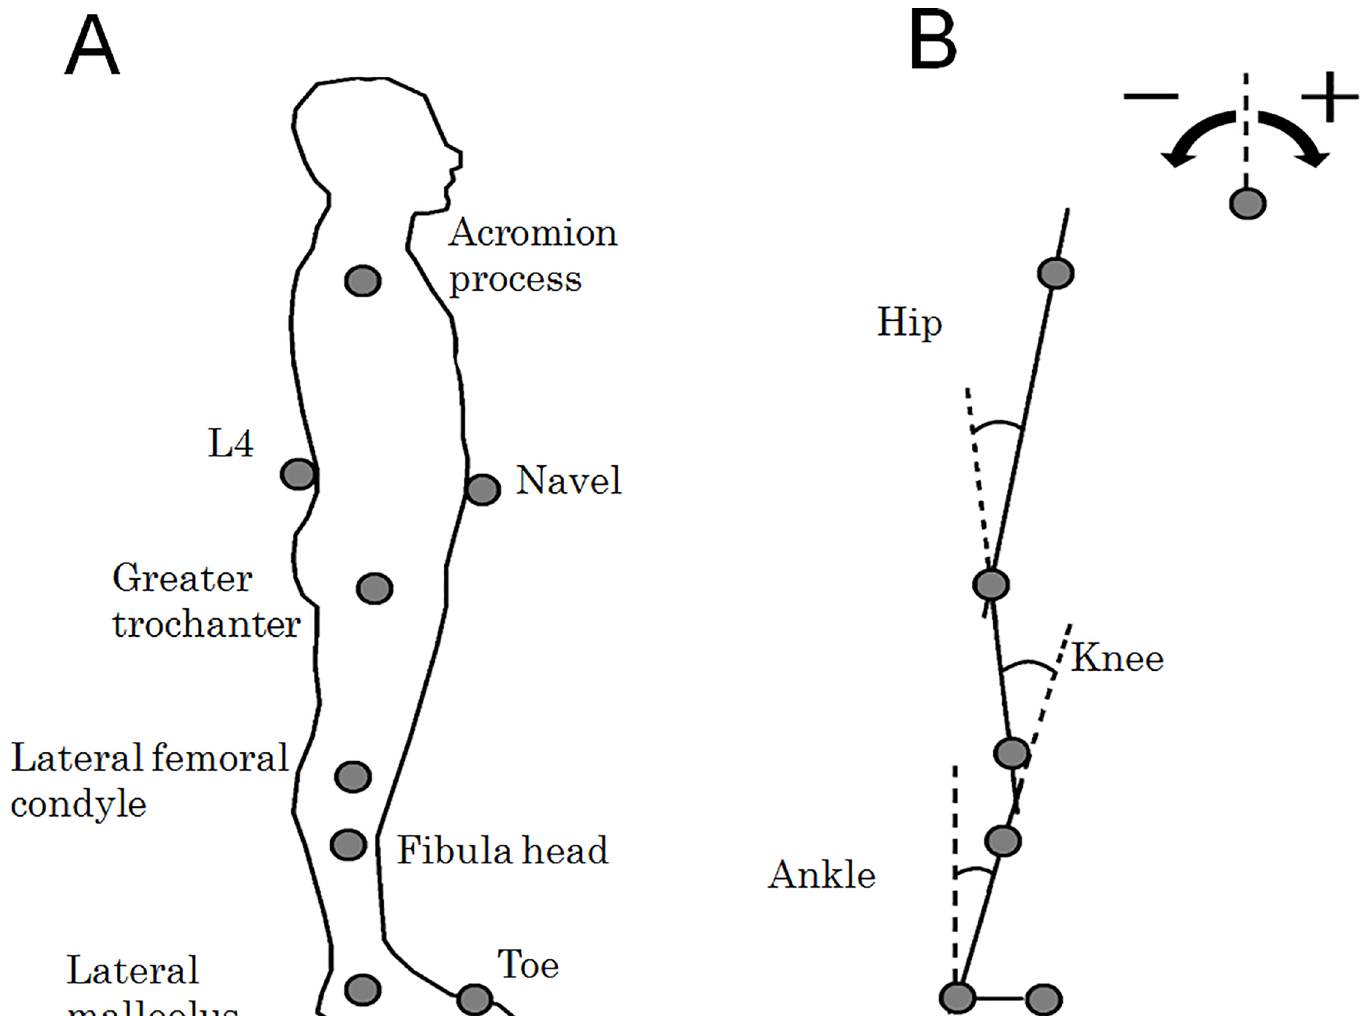
Fig 1. Experimental setup. (A) Marker placement: Eight reflective markers were placed over surface landmarks. The markers, except for L4 and the navel, were used to calculate the ankle, knee, and hip joint angles in the sagittal plane. The markers of L4 and the navel were used to calculate the abdominal breathing movement. (B) Definitions of joint angles: Joint angles were expressed as positive in the clockwise